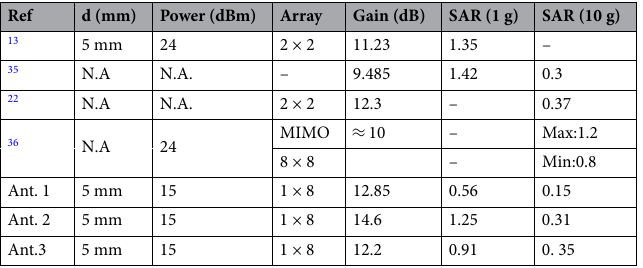
Table 5. Comparison the SAR of three antenna performances with other 5G antenna references at 28 GHz. d: Distance between antenna and human head model.